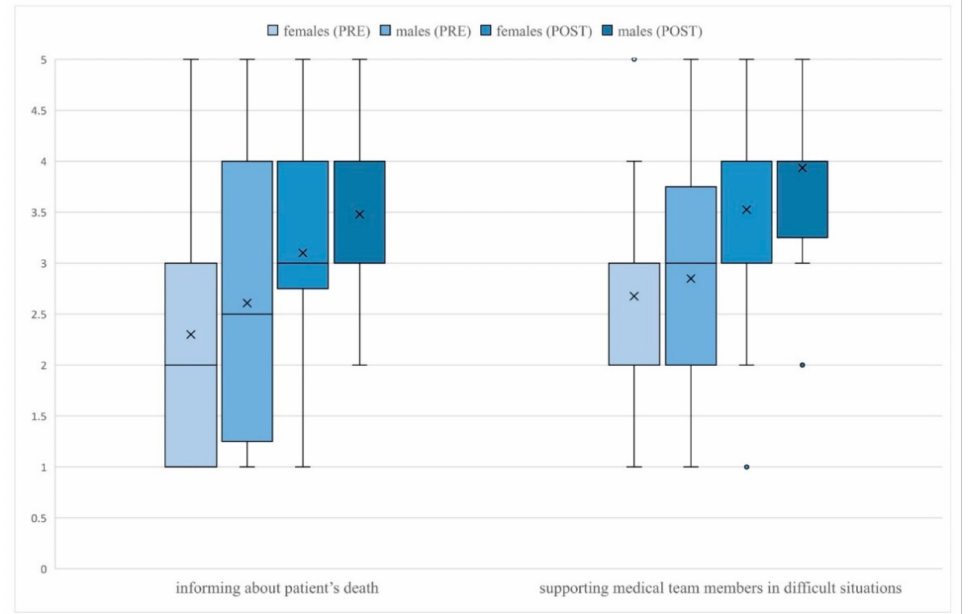
Figure 2. Gender differences in students’ self-efficacy